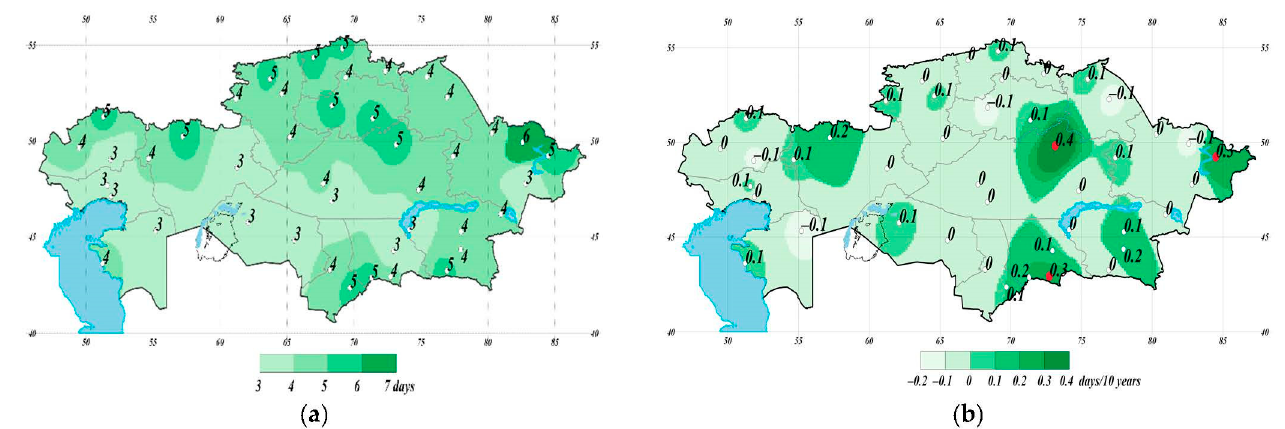
Figure 15. Spatial distribution of the index characterizing the maximum dry period duration (CWD) ( a ) and trends ( b ) of this parameter for the period 1971–2020.